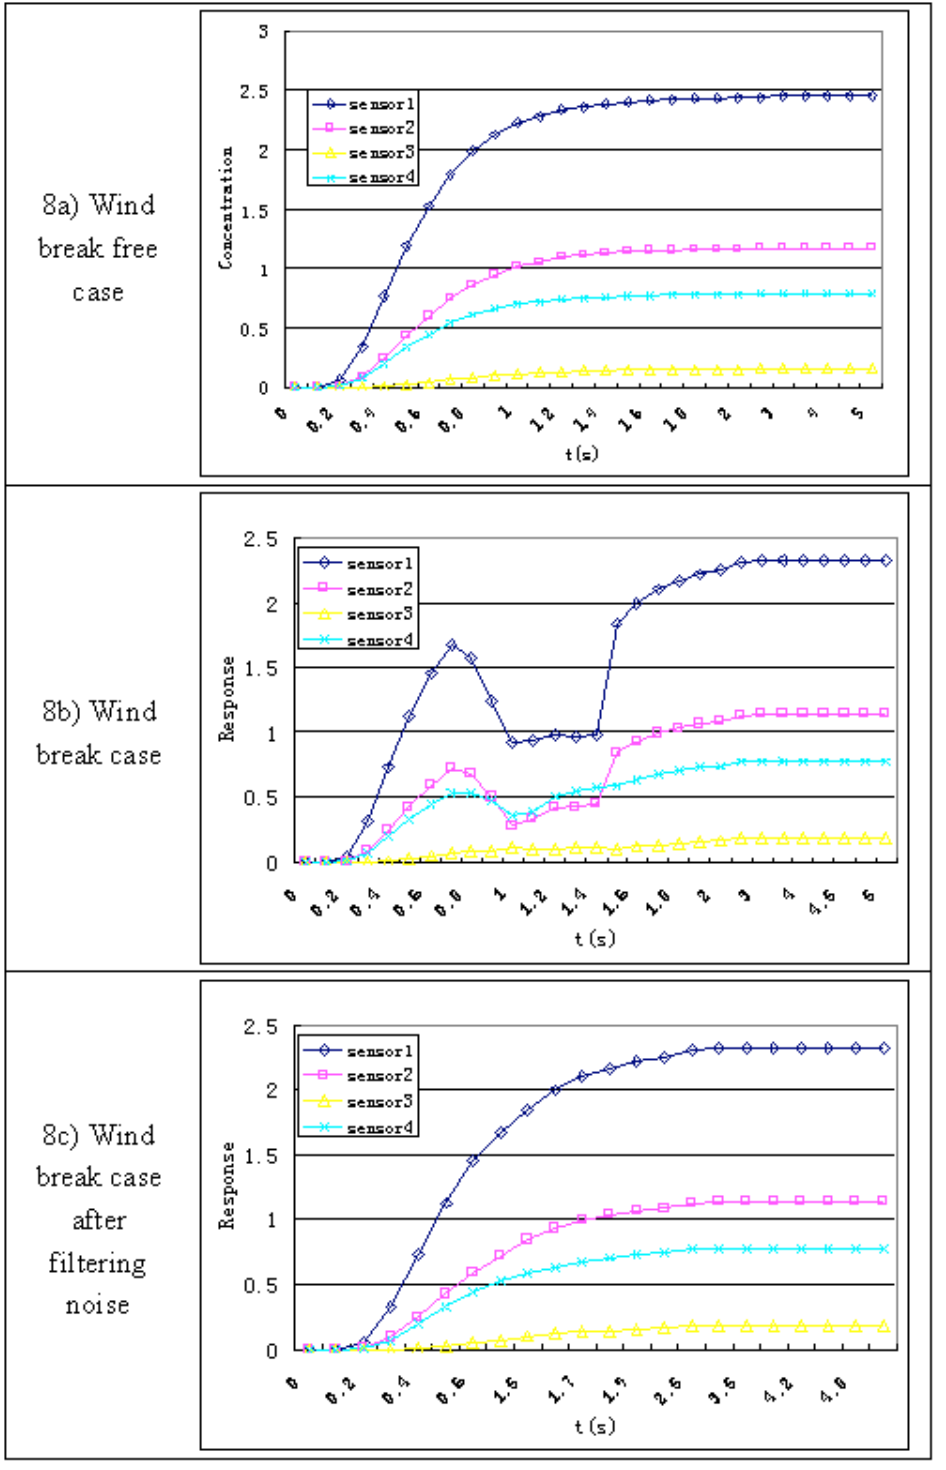
Figure 8 . Responses of Sensors for both Wind Break Case and Wind Break Free